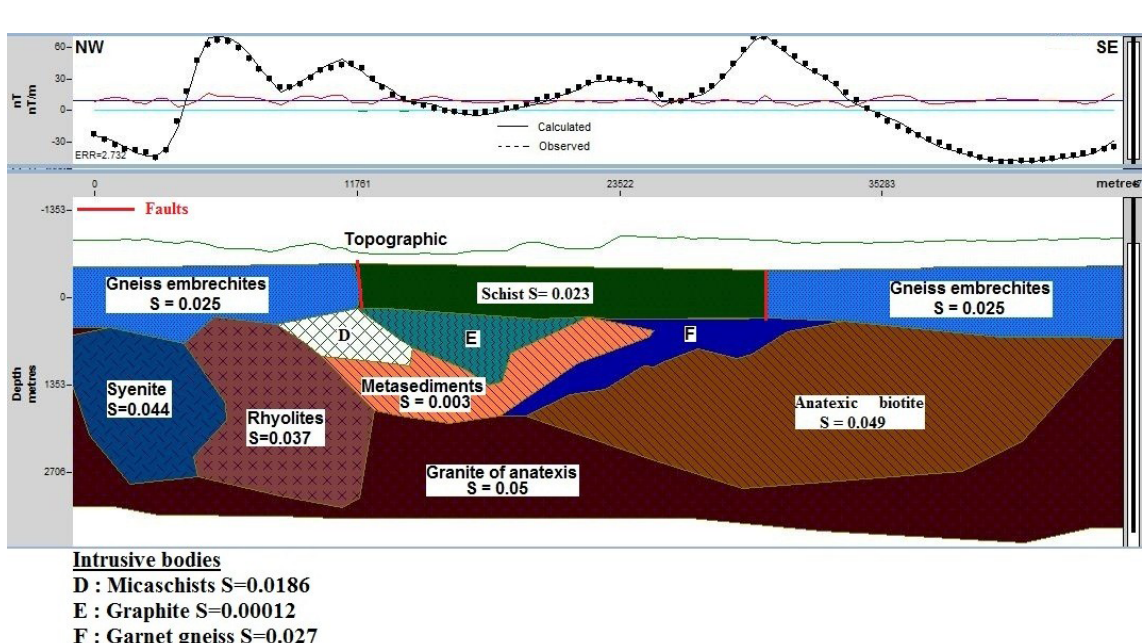
Figure 12. 2.75D model obtained from profile